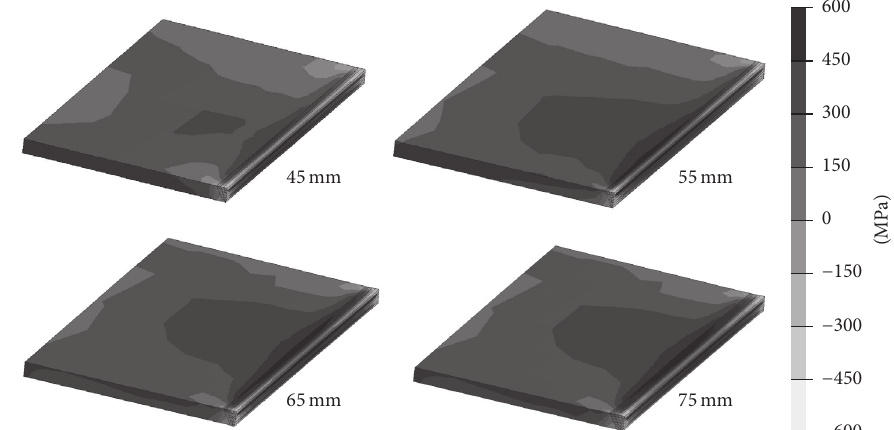
Figure 12: Transverse residual stress.